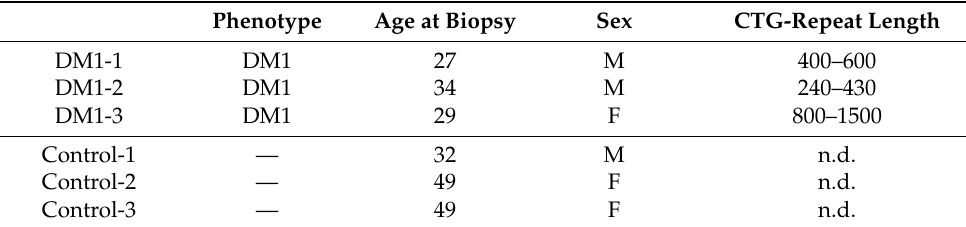
Table 1. List of patient and control tissue